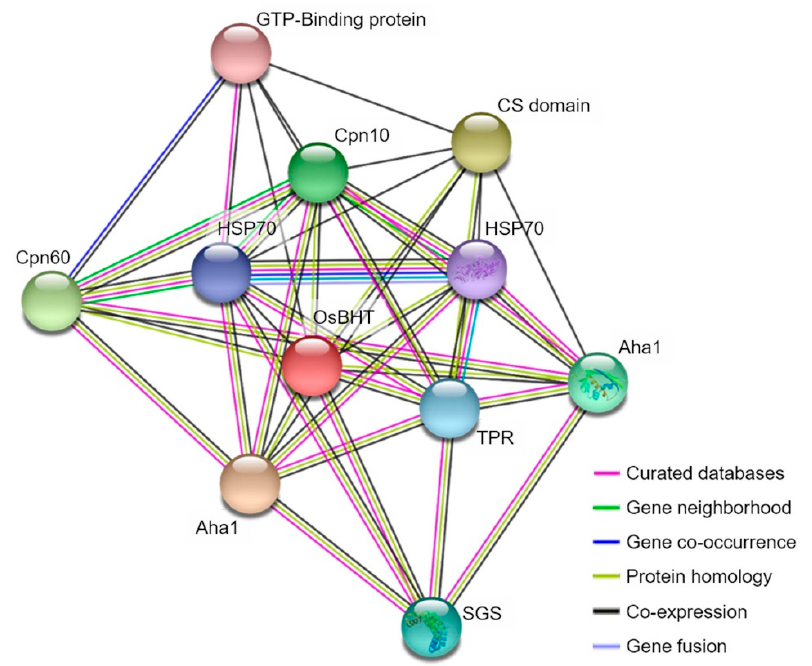
Figure 6. OsBHT protein interaction prediction. OsBHT interact with the heat shock protein. Signaled by the guanosine triphosphate (GTP)-binding protein when plants are exposed to high temperatures, Hsp70 and Hsp90 work together with multiple co-chaperones to prevent protein denaturation.